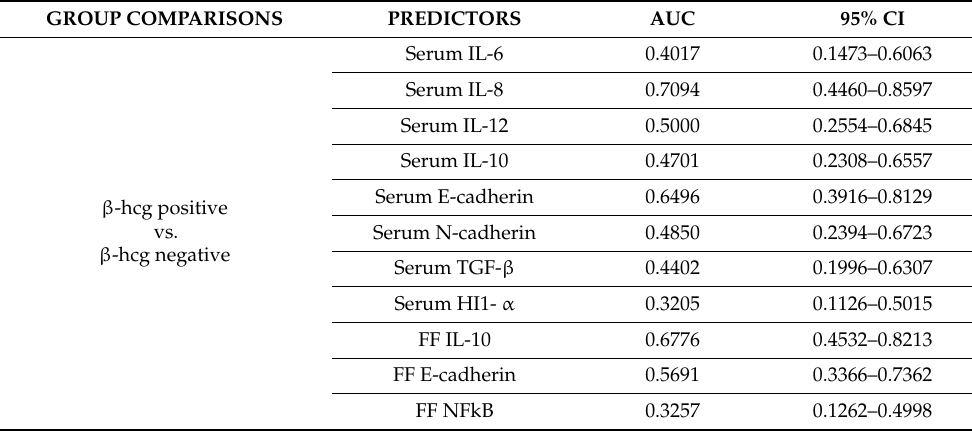
Table 4. Cont. Table 4. Diagnostic accuracies of serum and FF biomarkers in differentiating control women from EMS patients. AUROC, area under the receiving operating characteristic curve; CI, confidence in- terval.